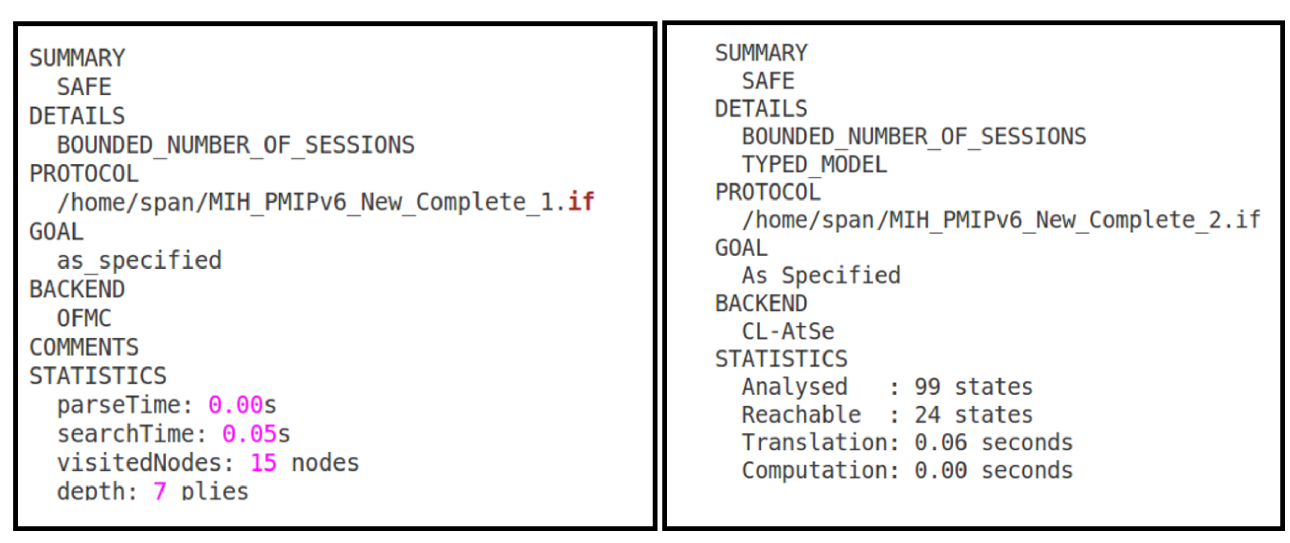
Fig 6. Avispa verification